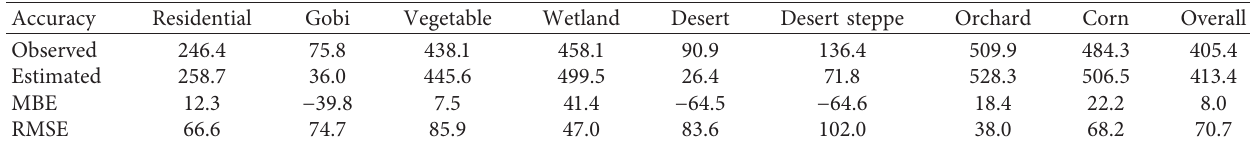
Table 2: Statistics of LE (W m − 2 ) modeling accuracy by TSEB u using ASTER images from eight dates at the HiWATER-MUSOEXE-12 at the 21 sites.